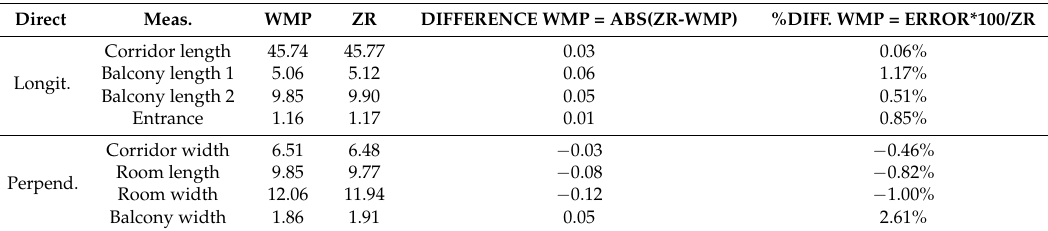
Table 8. Results of the 2D measurements for Case study 3, in meters.